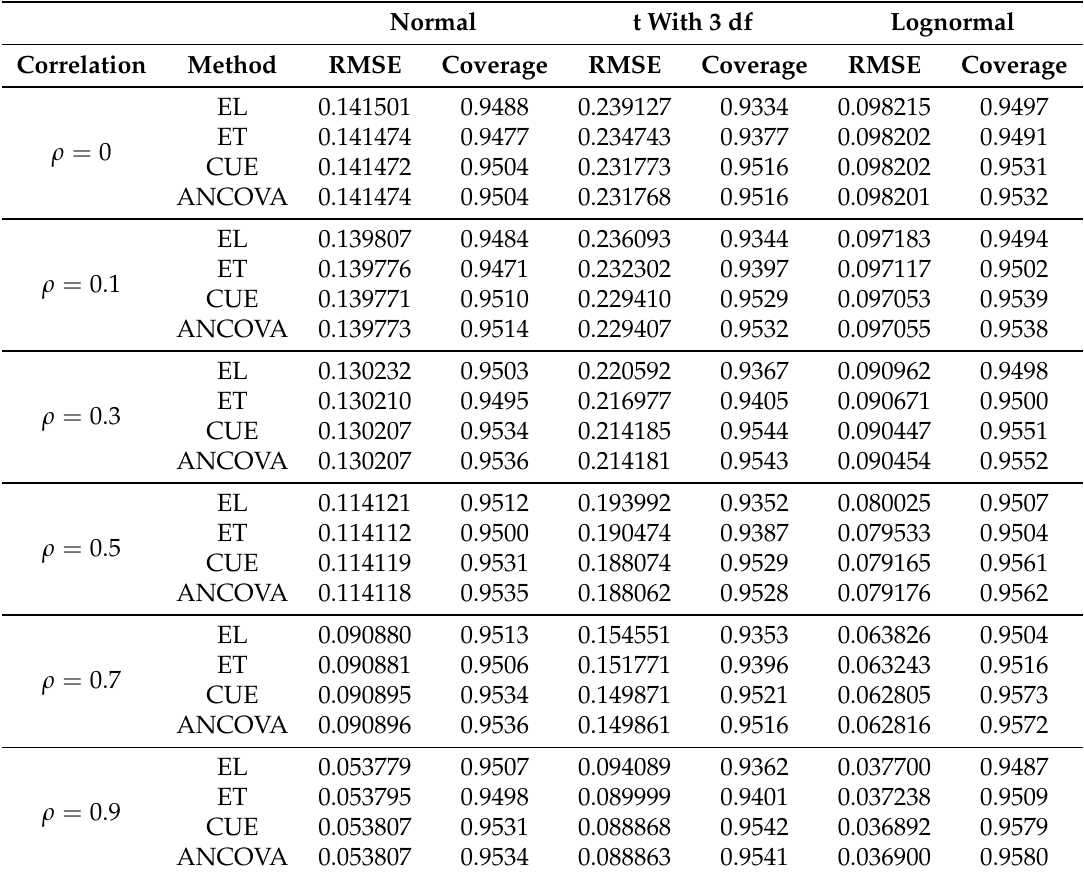
Table 3. Estimated root mean squared error and empirical coverage of nominal 95% confidence intervals (2